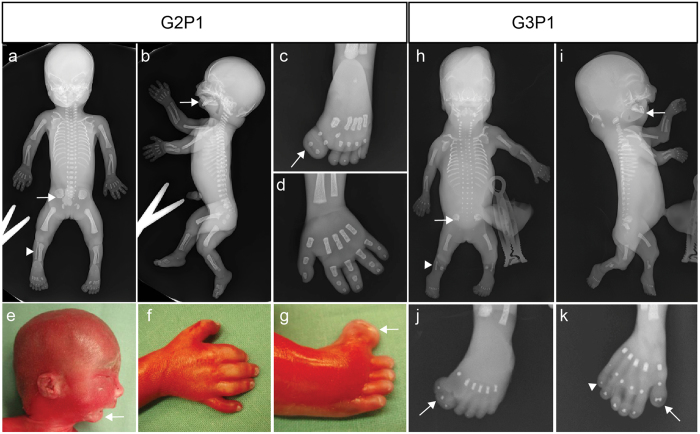
Clinical features of the two subjects in this study.(a–g) G2P1; (h–k) G3P1. Common features include short ribs, shortened long bones, micrognathia (arrow, b,e,i) and trident acetubula (arrow, a,h). G2P1 displayed preaxial polydactyly (duplicated hallux) of the feet (arrow, c,g), and no polydactyly of the hands, although digits appear short (d,f). G3P1 displayed preaxial polydactyly (triplicated hallux) of the feet (arrow j), and pre- (arrow, k) and postaxial (arrowhead, k) polydactyly of the hands. The tibiae in G3P1 were hypoplastic (arrowhead, h) but appeared normal in G2P1.